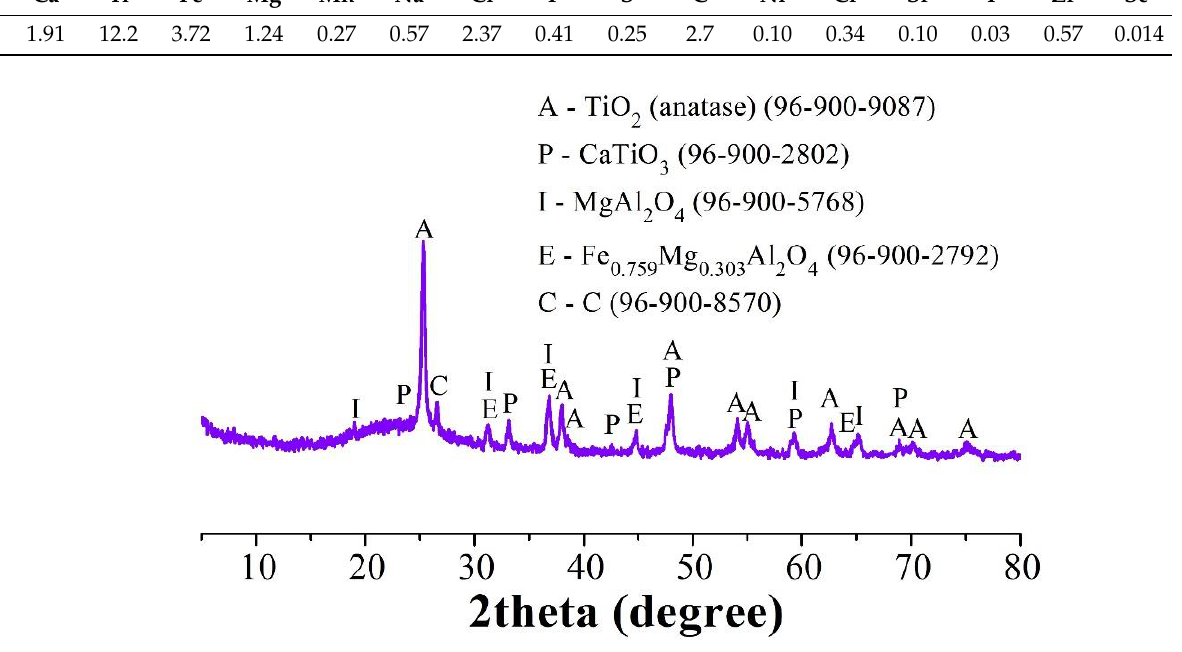
302 Table 5. Chemical composition of ACH precipitated from the mother liquor by saturation using gaseous HCl, wt.%. Al